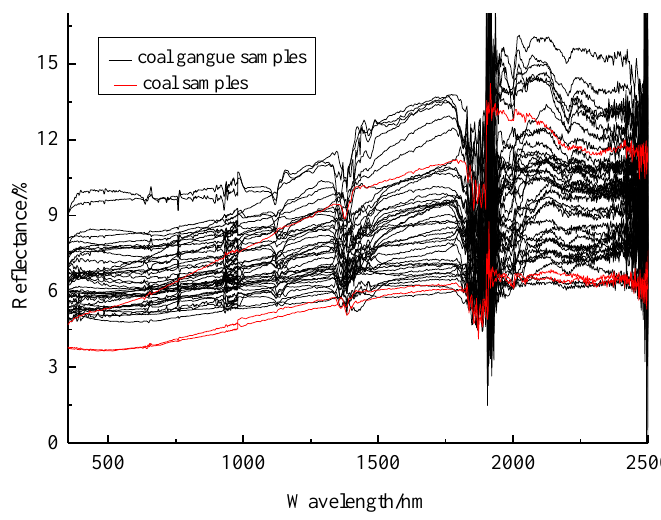
Figure 3. Visible, near-infrared spectrum of 42 coal gangues and three coal samples.